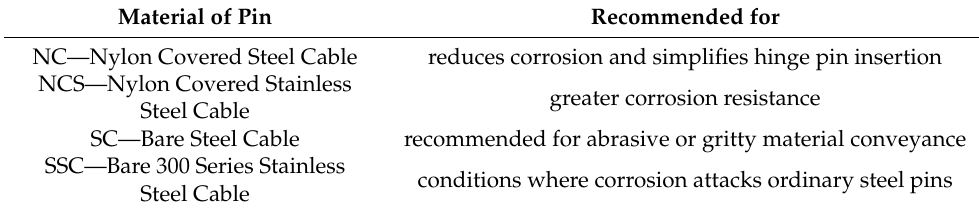
Table 7. Fastener Material Characteristics ranging from one plus sign (+) to four plus signs (+ + + +) [25]. Material of Fastener Magnetic